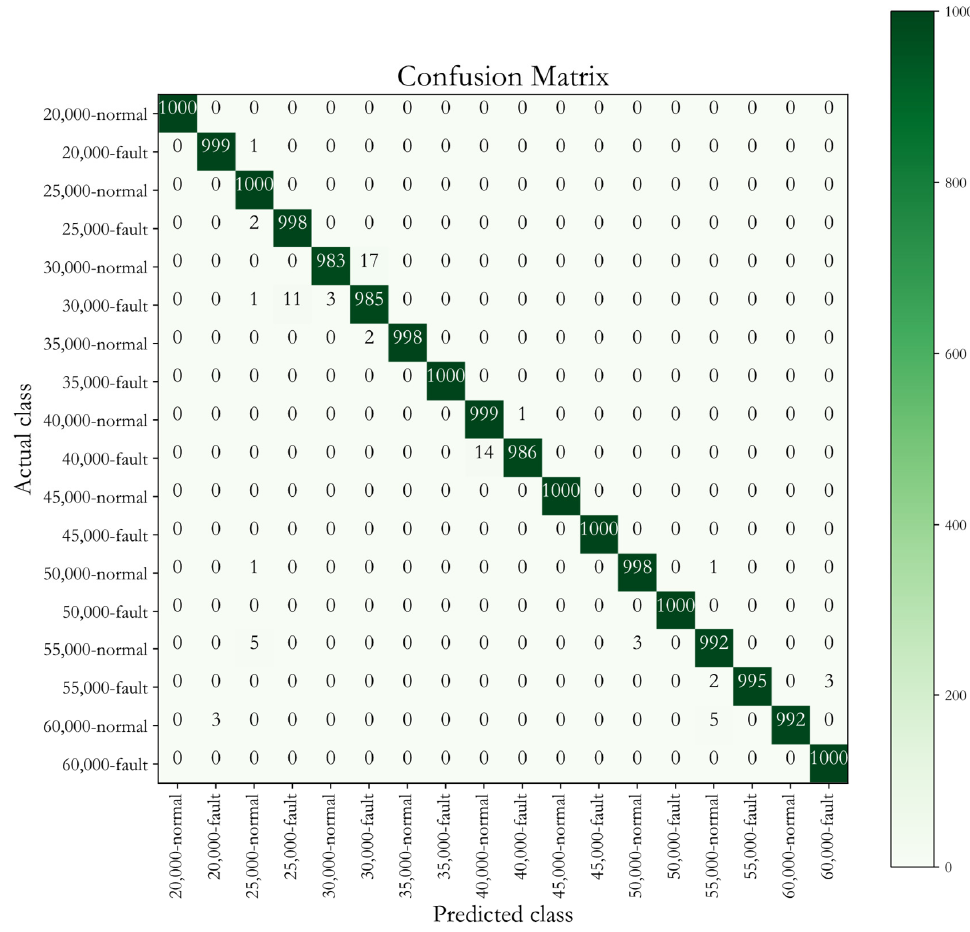
Figure 10. The confusion matrix for the fault classification.